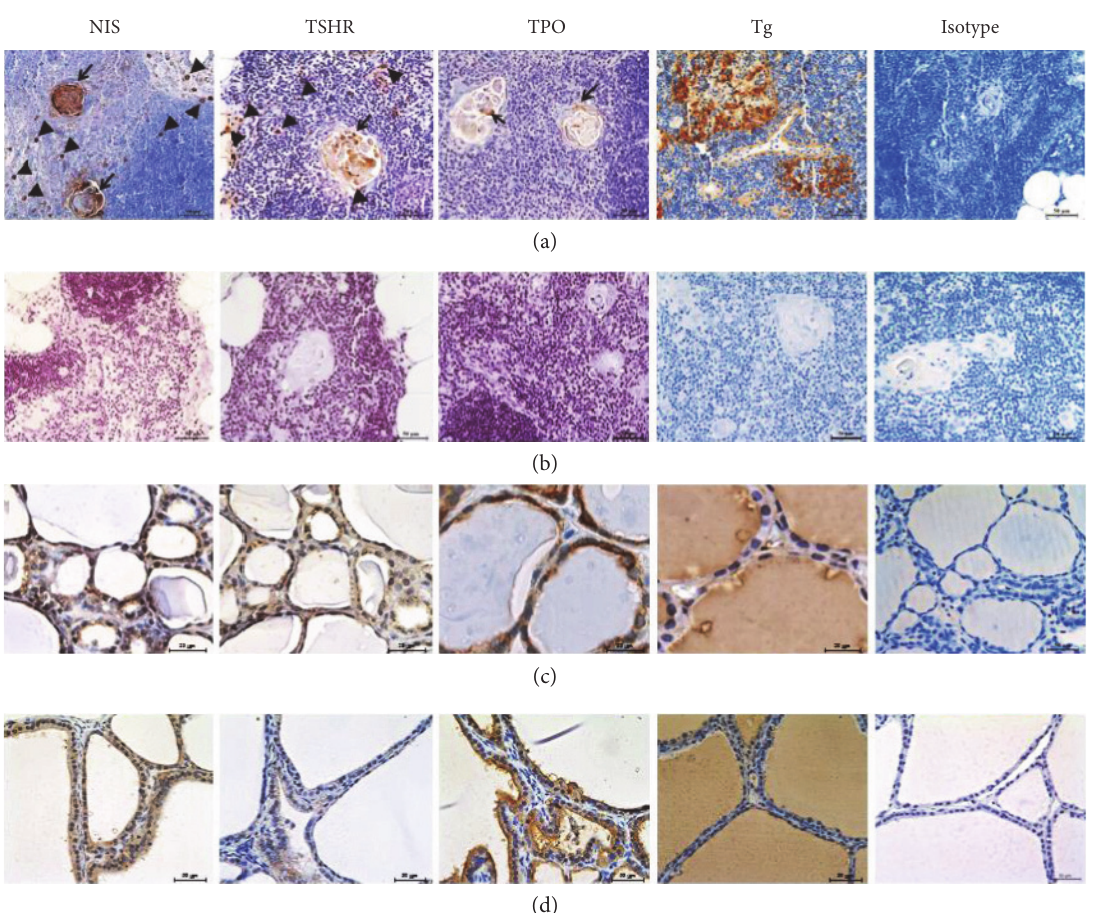
Figure 2: Expression of thyroid-related proteins in the thymus. Expression of thyroid-related proteins evaluated by immunohistochemistry. Representative images of thymic tissues that stained positive (a) or negative (b) for thyroid-related protein expression. The positive stained cells in Hassall ’ s corpuscles (arrows) and in thymocytes (arrowheads) are indicated. The expression of thyroid-related protein was observed in normal thyroid tissue (c) and thyroid tissue obtained from a patient with Graves ’ disease (d) as a positive controls. Representative images of isotype control are shown as a negative control. All images are magni fi ed 400x, and the scale bars represent 50 μ m (a, b, and d) and 20 μ m (c). NIS, sodium iodide symporter; TSHR, thyroid-stimulating hormone receptor; TPO, thyroid peroxidase; Tg,